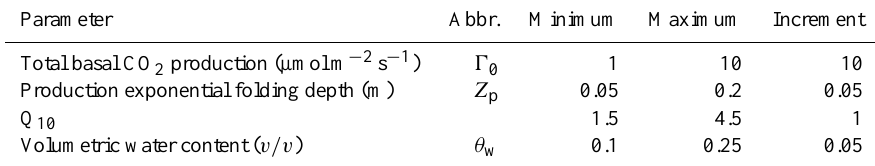
Table 3. Default parameter values for sensitivity